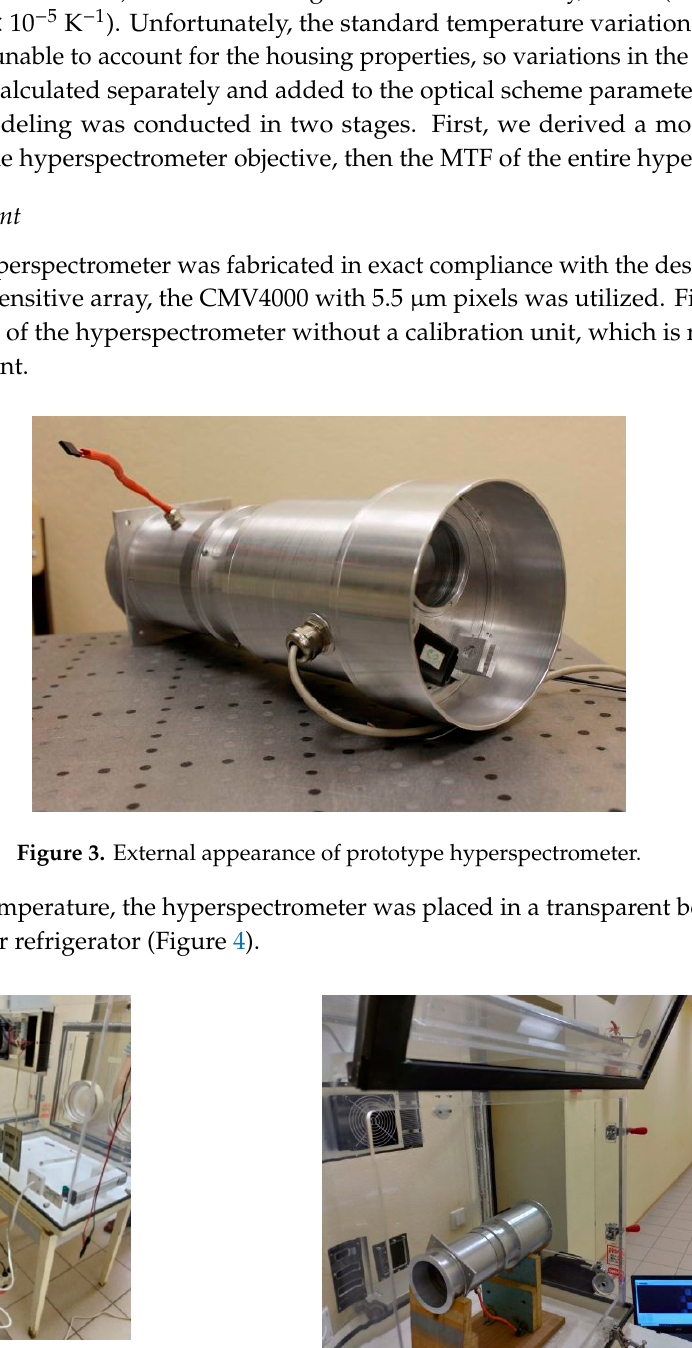
Table 2. Basic lengths of segments between scheme components at a temperature of 20 °C.